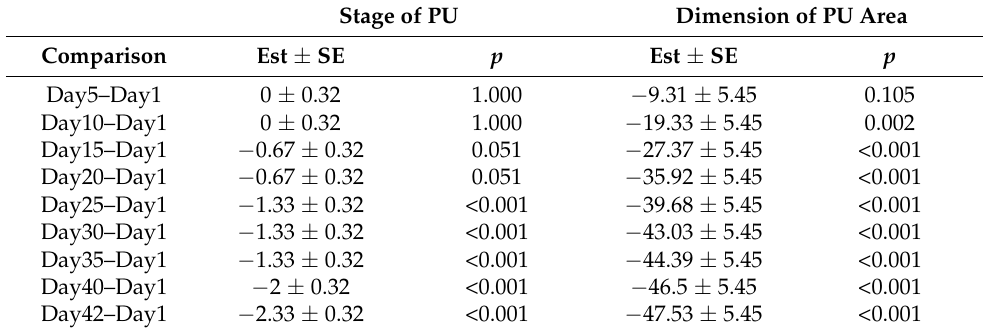
Table 4. Simple contrast results for the stage of PU, Braden score, and dimension of PU